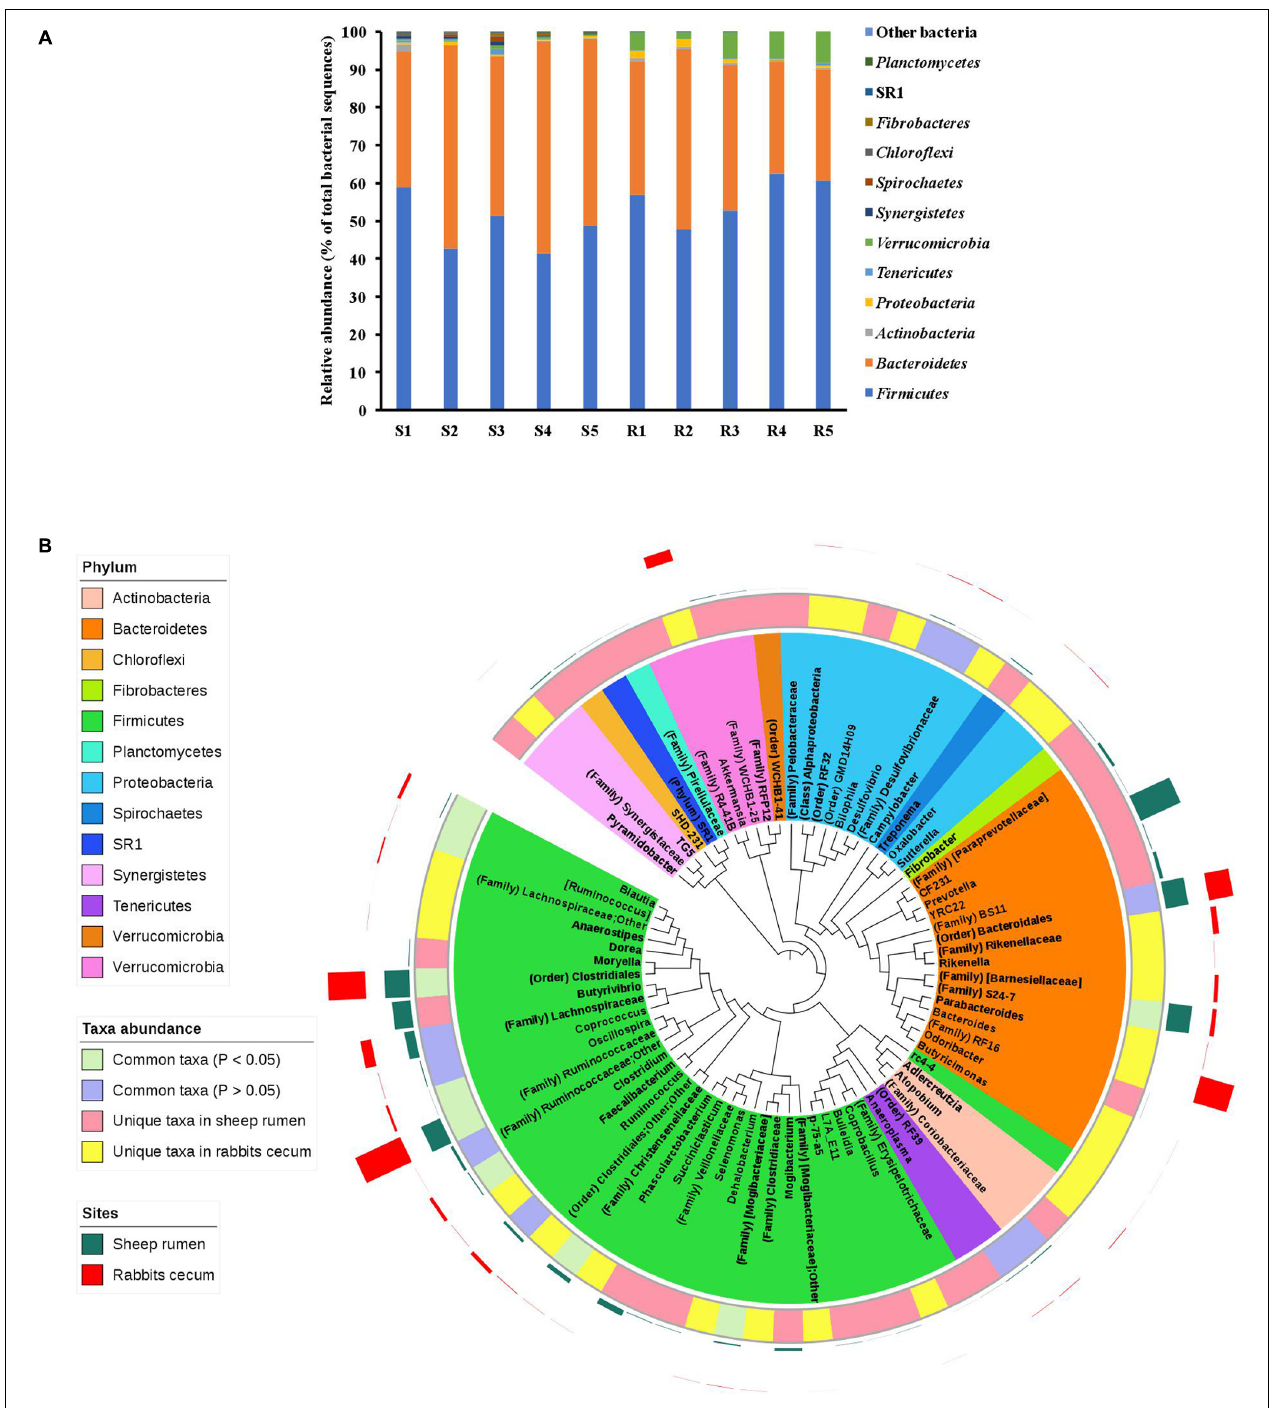
FIGURE 5 | Comparison of the bacterial microbiota in the sheep rumen and the rabbit cecum. (A) The relative abundance of bacterial phyla; (B) A neighbor-joining phylogenetic tree of the representative sequences of the OTUs that were graphically displayed in the Interactive Tree of Life. S1–S5, the five sheep; R1–R5, the five blocks of